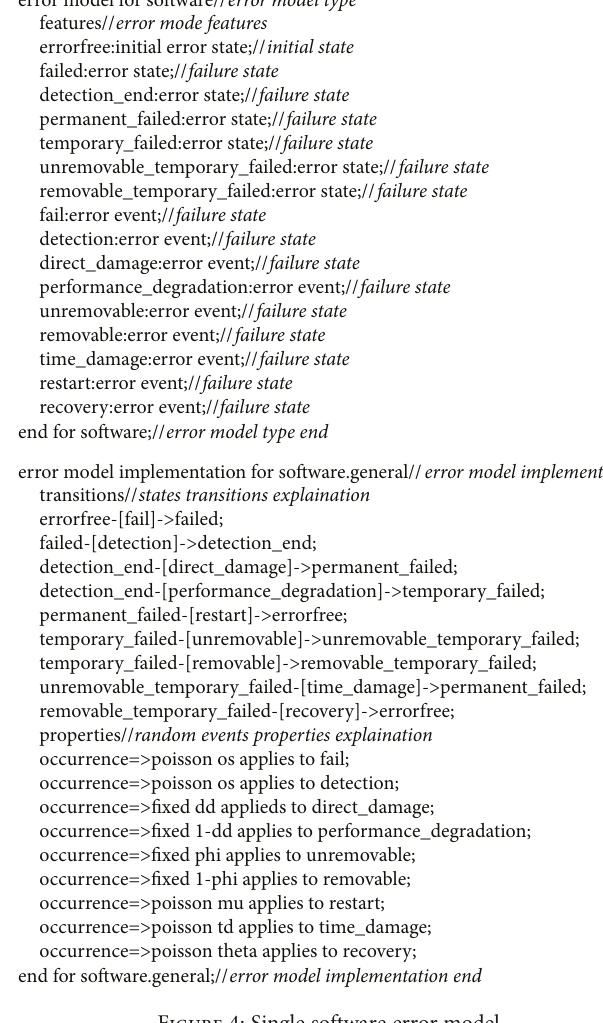
Figure 4: Single software error